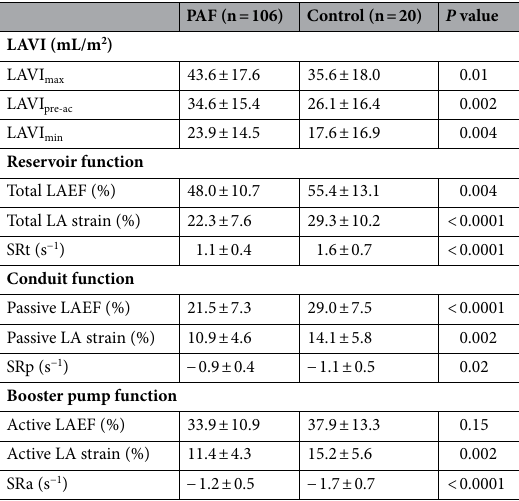
Table 3. Comparison of left atrial function and strain between the PAF and control groups. All data are shown as mean ± standard deviation. LAEF left atrial empty fraction, LAVI left atrial volume index, max maximum, min minimum, pre-ac pre atrial contraction, SR strain rate.